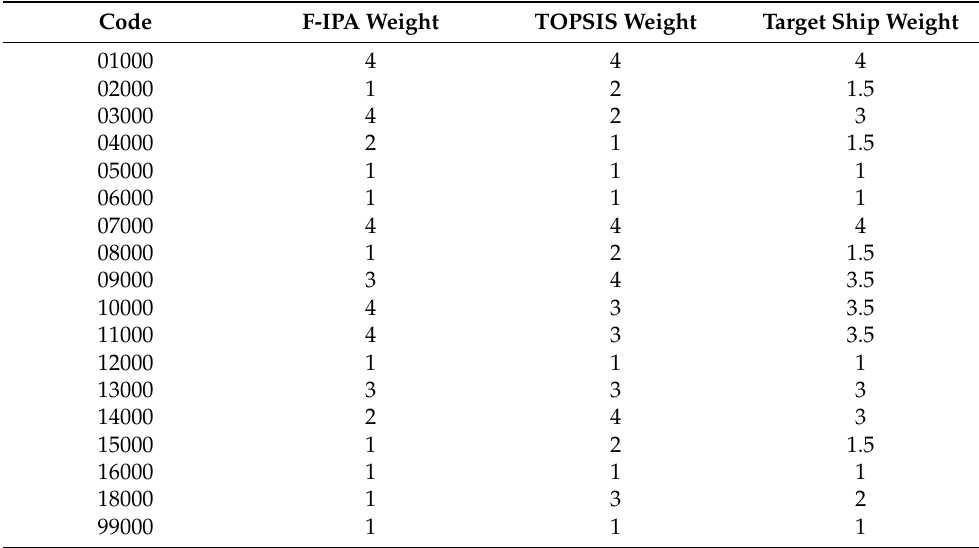
Table 10. Collation table of TOPSIS weight, F-IPA weight and Taiwanese ships weight.